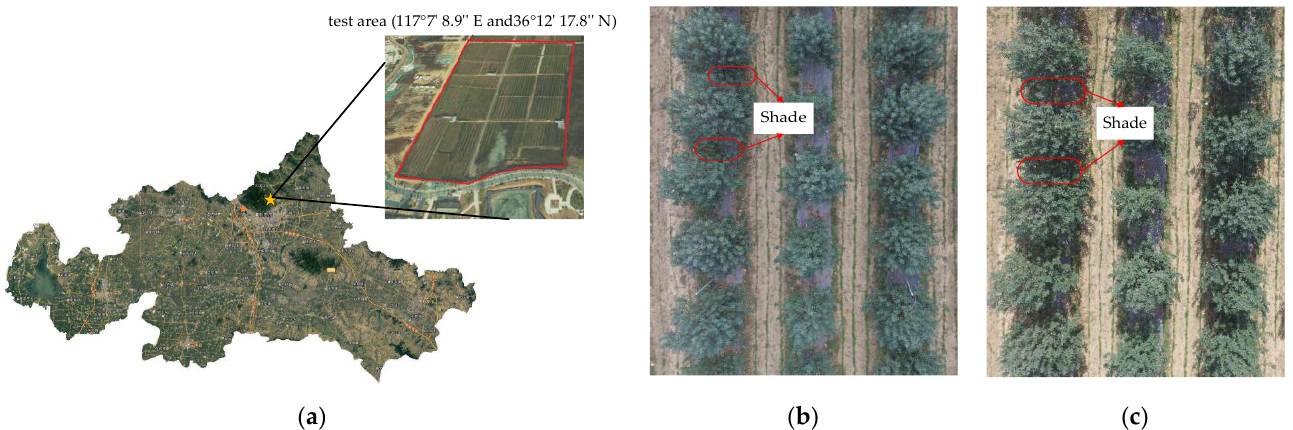
Figure 1. Test site and illustrations of the images under different lighting conditions: ( a ) test area in Taian, Shandong, China, ( b ) cloudy day without direct solar illumination, and ( c ) sunny day, with direct solar illumination.